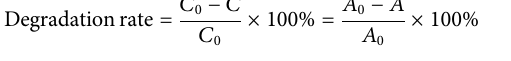
Figure 4B, the bandgap can be calculated by the Kubelka- Munk method: